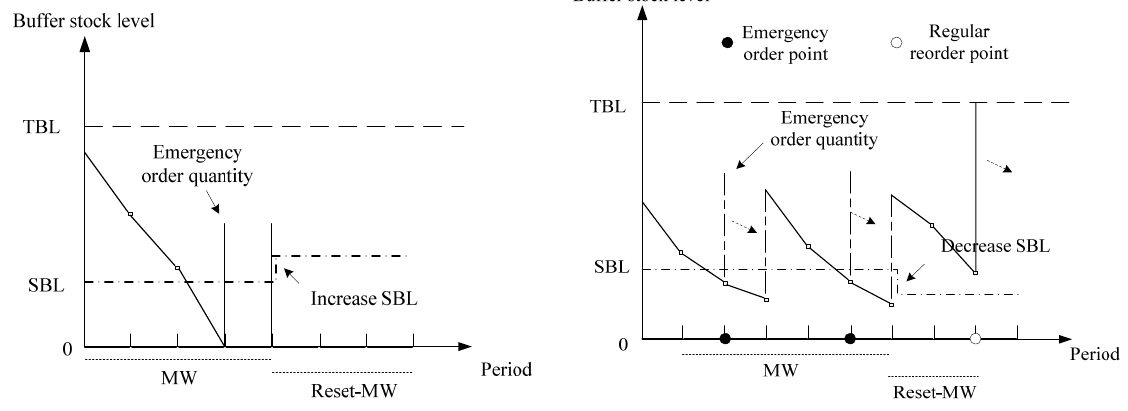
Fig. 3. Safety buffer stock level adjust procedure (Source Ref.